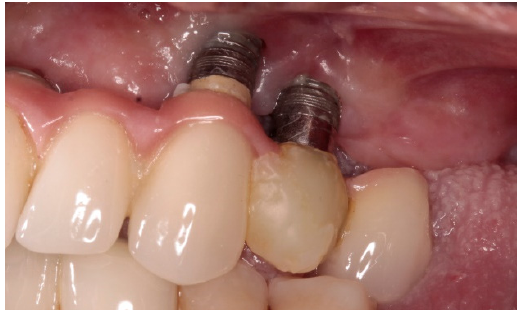
Figure 1. Absence of keratinized mucosa implant 2.3.